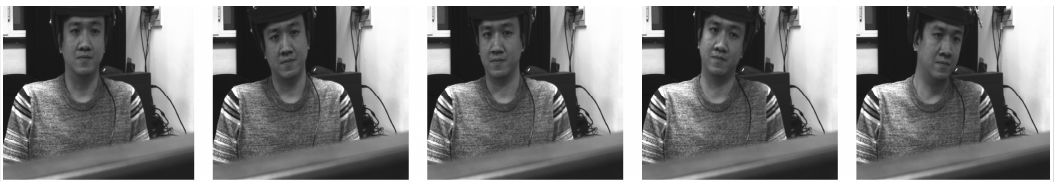
Figure 11. The motion capture system based on inertial technology.